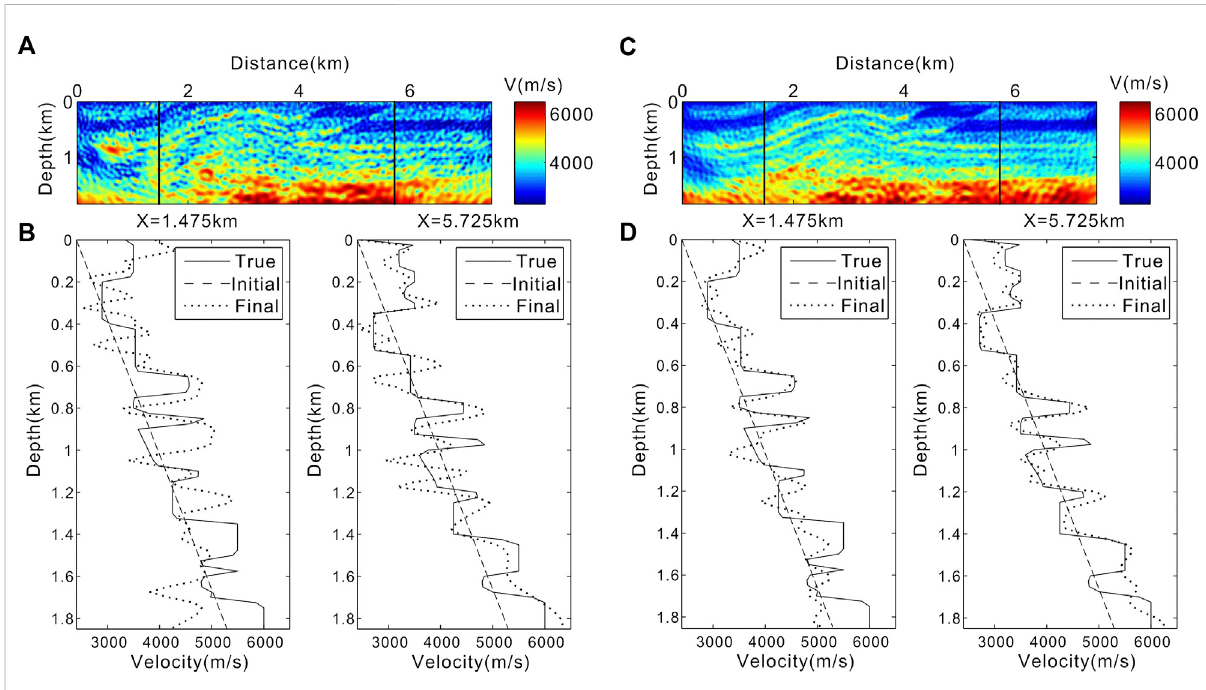
FIGURE 9 The results of frequency-domain FWI with noise-added data. (A) Reconstructed model using the L-BFGS method. (B) Two vertical traces extracted from model (A) at x=1.475 and 5.725 km. (C) Reconstructed model using the mL-BFGS method. (D) Two vertical traces extracted from model (C) at x=1.475 and 5.725 km. Solid line: the true velocity; dashed line: the initial velocity; dotted line: the reconstructed velocity.